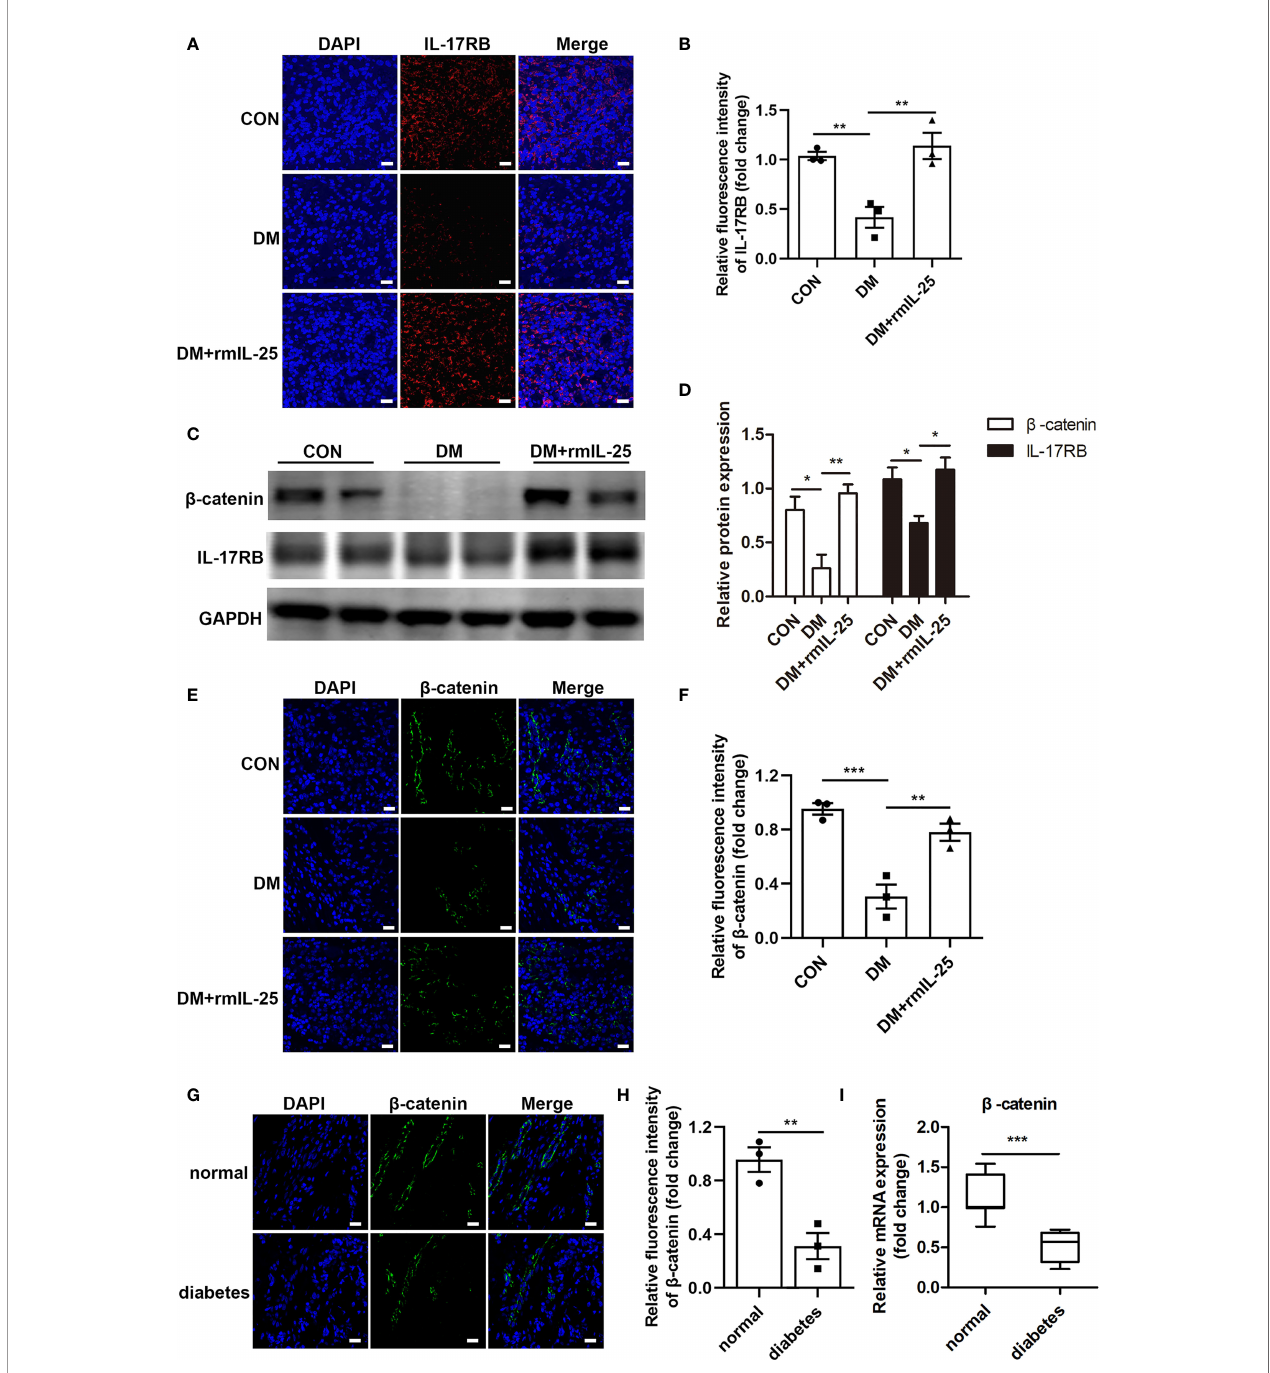
FIGURE 4 | IL-25-upregulated-IL-17RB facilitates wound healing in diabetic mice by rescuing b -catenin expression. (A) Representative immuno fl uorescent staining for IL-17RB (red) and DAPI (blue) in wound edge skin (day 7 post injury) from groups of control (CON), diabetic (DM) and diabetic with rmIL-25 injection mice (DM + rmIL-25). Scale bars, 20 m m. (B) Quanti fi cation of IL-17RB in A is shown (n = 3). (C) Representative western blotting image of b -catenin and IL-17RB in wound skin (day 7 post injury) from groups of CON, DM and DM + rmIL-25. (D) Quanti fi cation analysis of b -catenin and IL-17RB protein in C is presented (n = 3). (E, F) Protein expression level of b -catenin (green) in wound skin (day 7 post injury) from group of CON, DM and DM + rmIL-25 was evaluated by immuno fl uorescent staining (E) and the quanti fi cation analysis was shown (n = 3) (F) . Scale bars, 20 m m. (G) Representative immuno fl uorescent staining for b -catenin (green) and DAPI (blue) in wound edge skin from diabetic patients with DFU and normoglycemic individuals. Scale bars, 20 m m. (H) Quanti fi cation analysis of the b -catenin protein expression from G (n = 3). (I) b -catenin mRNA expression in the wound edge skin from diabetic patients with DFU (n = 11) and normoglycemic individuals (n = 7) was analyzed by qPCR. * P < 0.05, ** P < 0.01, *** P <